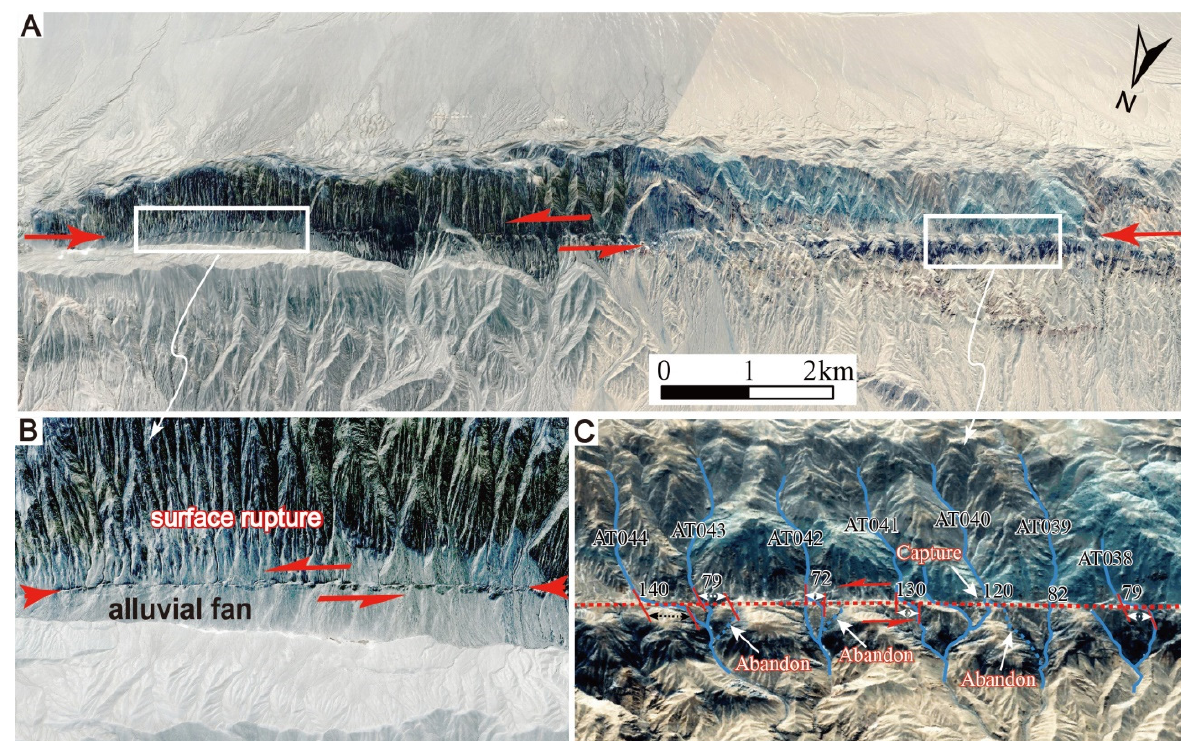
Figure 3. ( A ) SRTM 90 m resolution color-shaded relief map showing the topography features and offset large river channels (see Figure 1B for location, Table S1 for measurement uncertainty). ( B ) High-resolution Google Earth images showing the offset of small rivers (AT024–AT030) with a short upstream length. Red dotted line indicates the active fault trace. All the offsets are in meters.